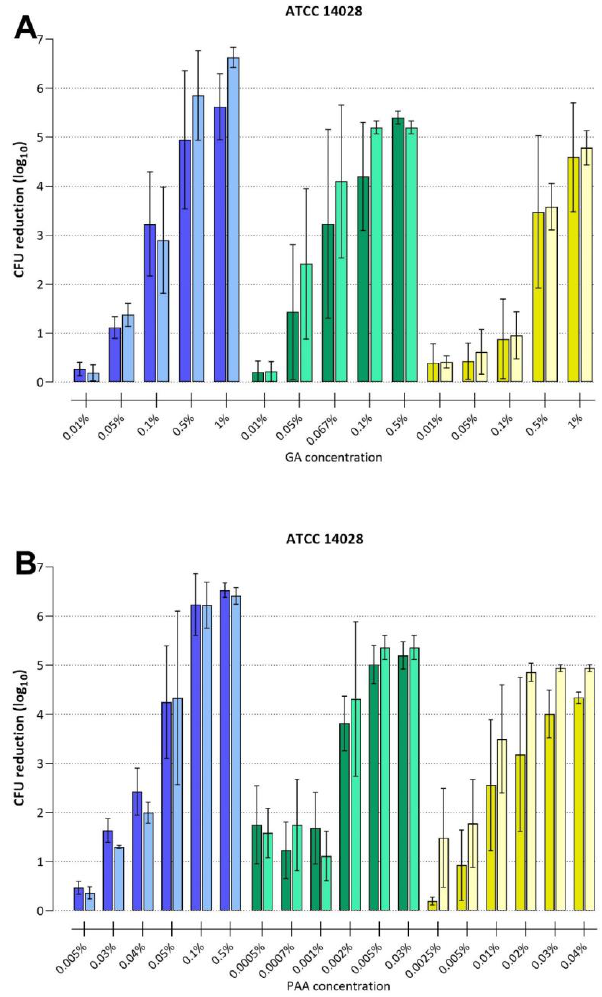
Figure 5. The intra-laboratory reproducibility testing of S. Typhimurium ATCC 14028 biofilm disinfection with GA ( A ) or PAA ( B ). The color scheme is identical with previous figures (GBA: blue, PCA: green, and SSCA: yellow), while bright and dark bars indicate results from two different technicians. Bars represent the mean with a standard deviation of three individual experiments performed by the same technician with at least two biological replicates per experiment. Note the variations in GA and PAA concentrations used in all three assays as well as assay-specific detection limits (1, 2, and 3 log 10 for GBA, PCA, and SSCA, respectively).